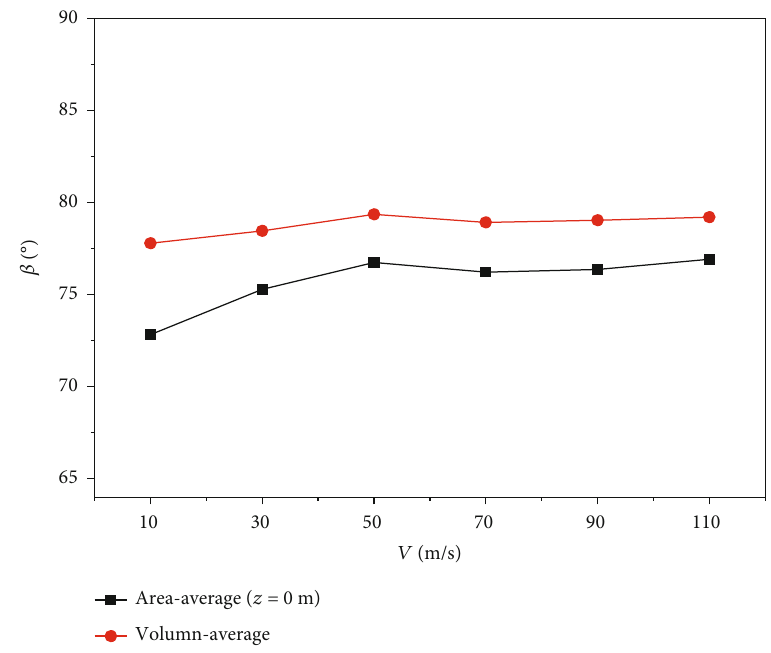
Figure 27: Volume average synergy angle and area average synergy angle under di ff erent inlet velocities.